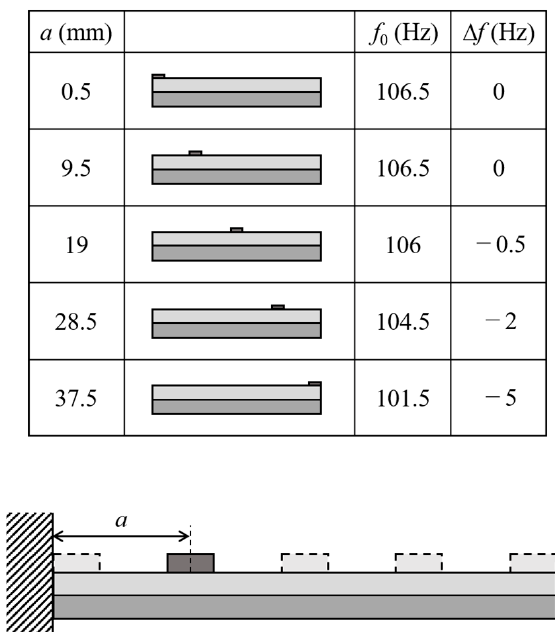
Figure 4. Measured and calculated frequency shift versus load or weight.